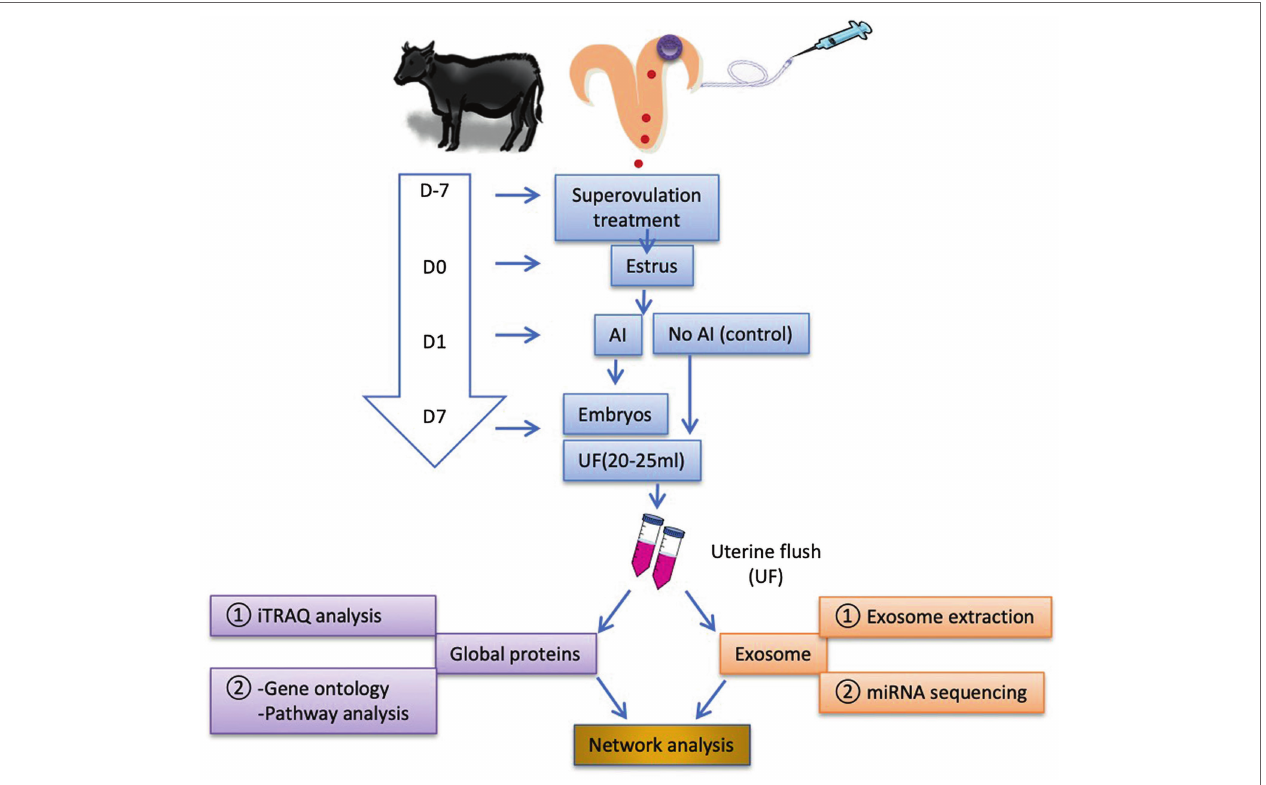
FIGURE 1 | Schematic illustration of the experimental design. Cows were superovulated 7 days before the estrus (D7). In estrus (D0), the cows were either inseminated (AI cows) or non-inseminated (Ctrl cows) on D1. The embryos were flushed out on D7, and the first uterine flush (UF) was collected (20–25 ml). To reduce individual variations in the animal responses and the cost for analyses, the equal volume of UF samples was pooled together (UF from each three AI cows and each two Ctrl cows were pooled as a single sample, respectively; thus, three pooled AI UF from nine cows and three pooled Ctrl UF from six cows) and stored at − 80 ° C until use. The number of recovered embryos with good quality per AI cow was 9.5 ± 1.4 (mean ± SEM). Global UF protein analysis was performed using isobaric tags for relative and absolute quantification (iTRAQ) analysis followed by GO and enriched signaling pathway analyses. Exosomes were isolated from D7 UF followed by RNA extraction and microRNA (miRNA) sequencing for the identification of exosome-derived miRNAs contents. The identified proteins and miRNAs were mapped to network analysis. AI, artificial insemination; UF, uterine flush; and D,